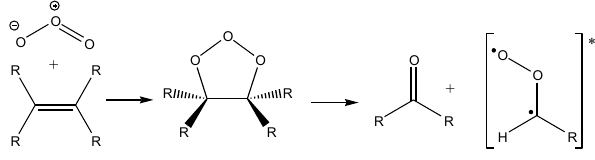
Scheme 1. A schematic diagram of the reaction mechanism of ozonolysis of alkenes.